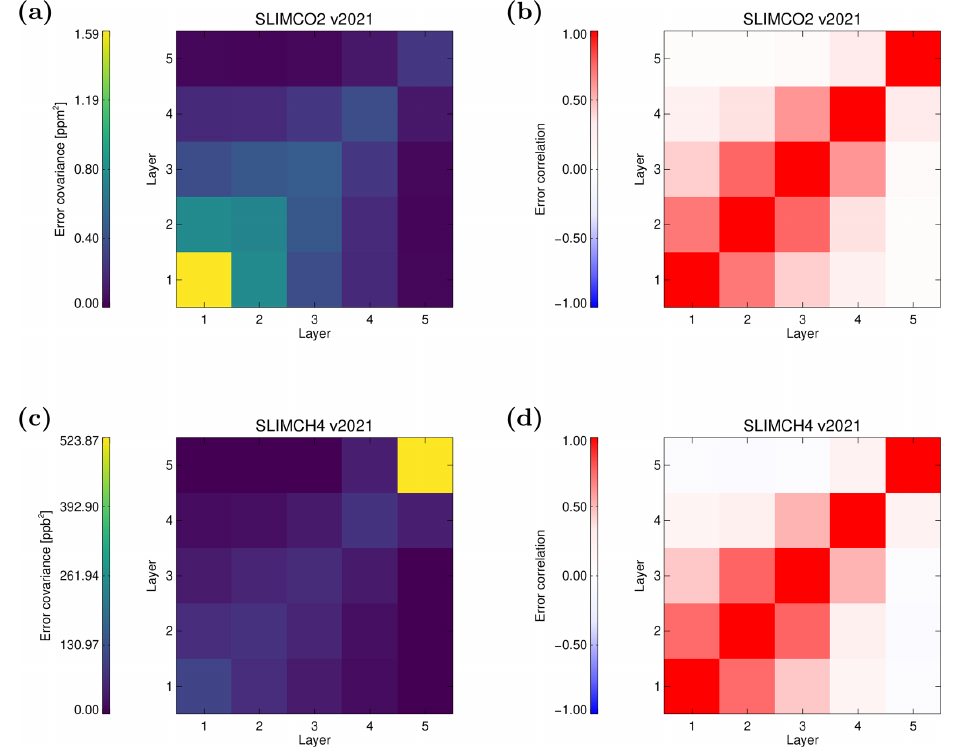
Figure A4. Error covariance matrices for SLIMCO2 (a) and SLIMCH4 (c) and corresponding error correlation matrices (b, d)